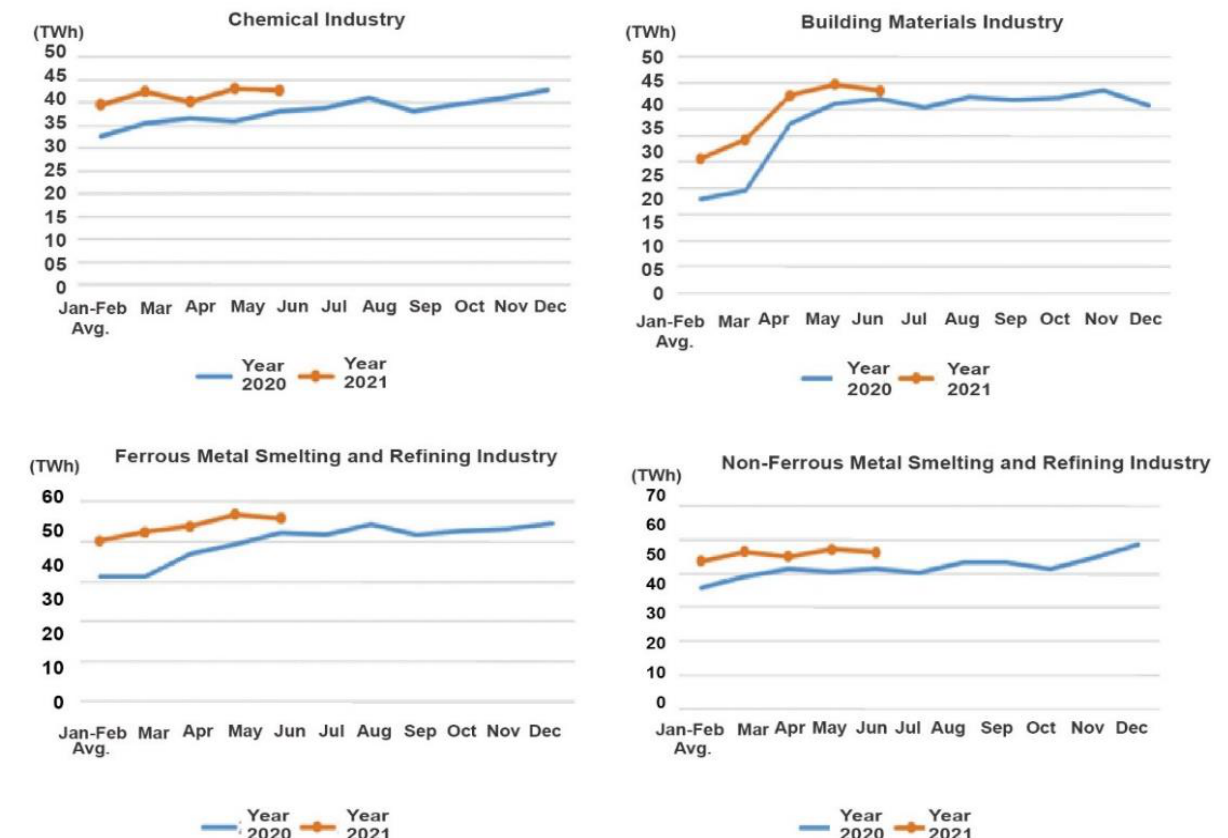
Figure 19. Monthly electricity consumption of key industries in years 2020–2021 [75]. Source: CEC (2021) Statistics of Electricity Consumption. All rights reserved.